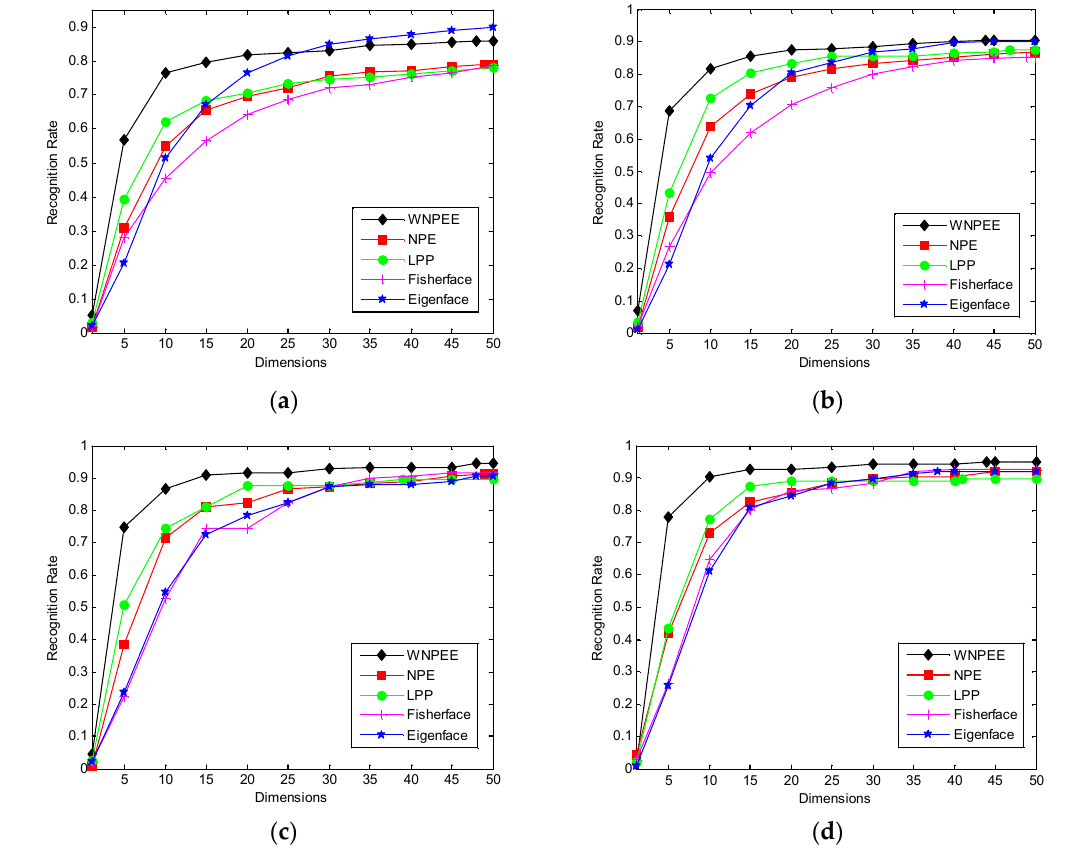
Table 4. Computation time on CMU PIE face database under different trains for one run (time in seconds).